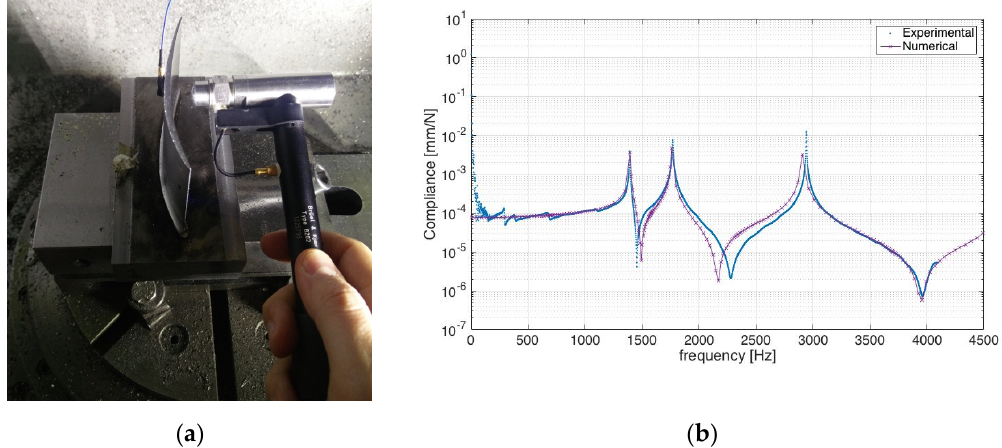
Figure 8. Workpiece driving point frequency response functions (FRFs): ( a ) experimental setup ( b ) comparison with numerical FRF.